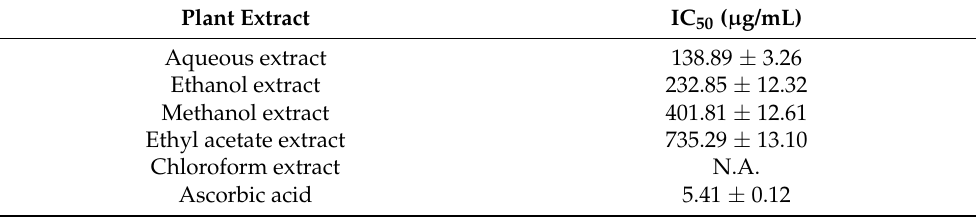
Table 2. IC 50 values for the antioxidant activities of the plant